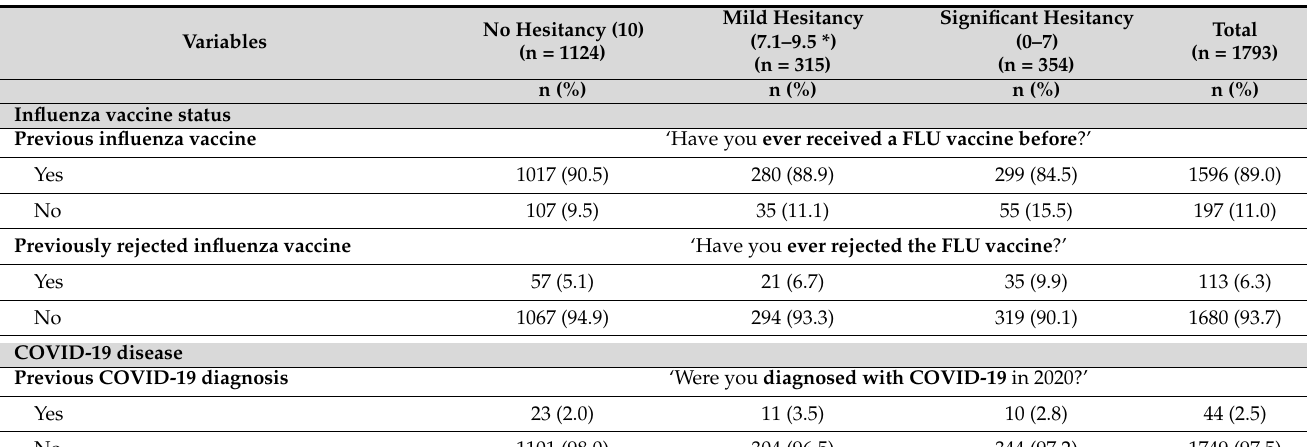
Table 2. Vaccination-related factors according to participants’ likelihood to receive a COVID-19